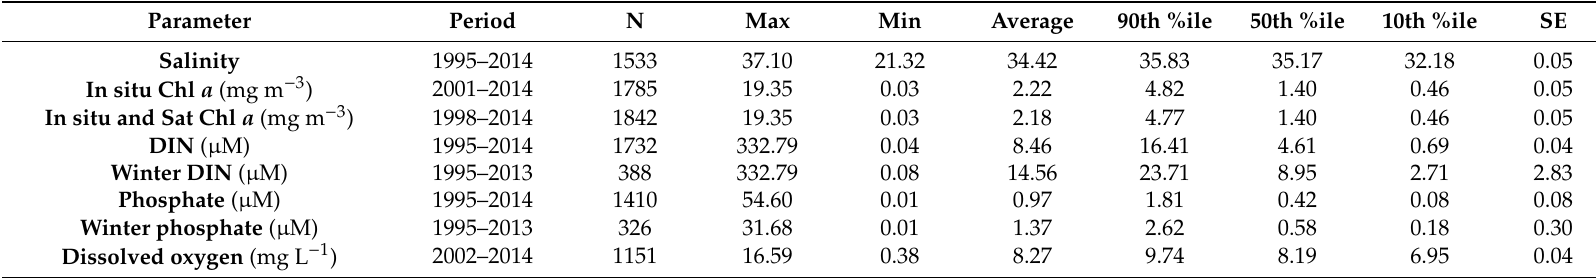
Table 1. Main statistical parameters for following variables: salinity, Chl a (mg m − 3 ), dissolved inorganic nitrogen (DIN; µ M), phosphate ( µ M) and dissolved oxygen (DO; mg L − 1 ). Please note the 90th, 50th, and 10th percentiles (90th %ile, 50th %ile and 10th %ile) and the standard error